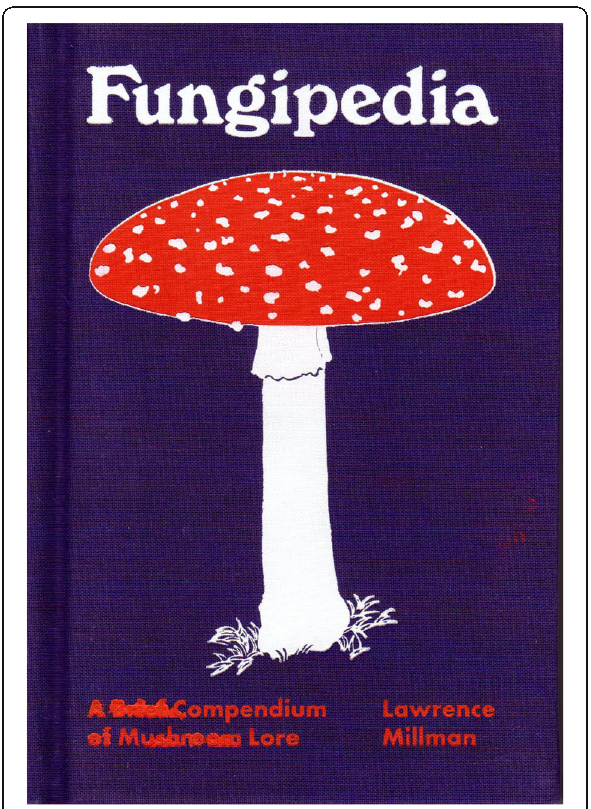
Fig. 21 Fungipedia: a brief compendium of mushroom lore